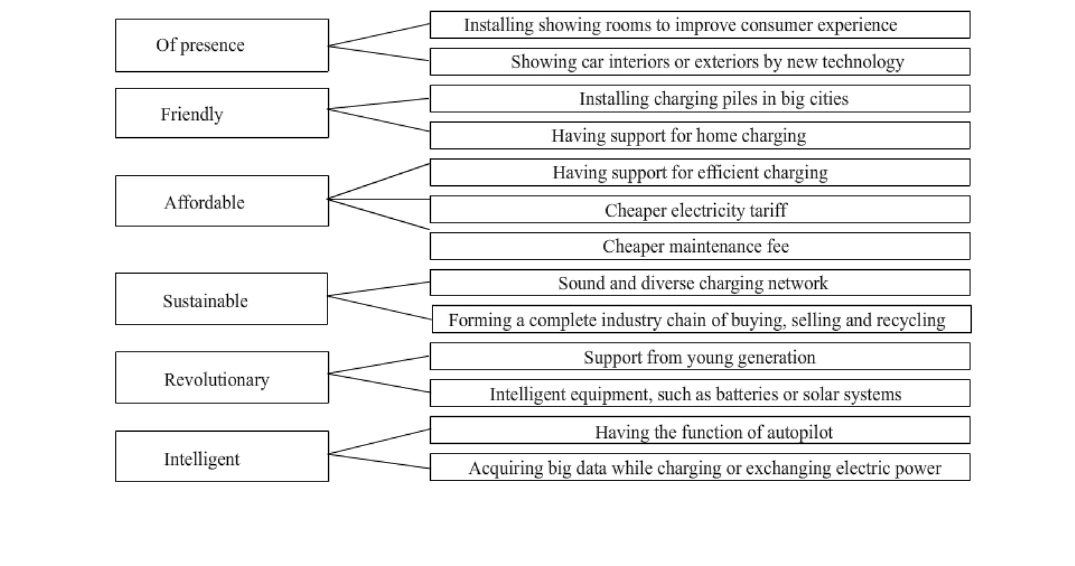
Fig. 1 An example of a participant’s evaluation